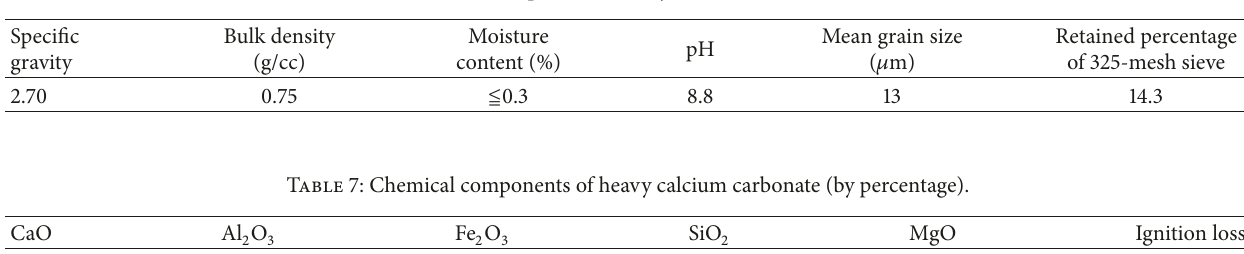
Table 6: Properties of heavy calcium carbonate.